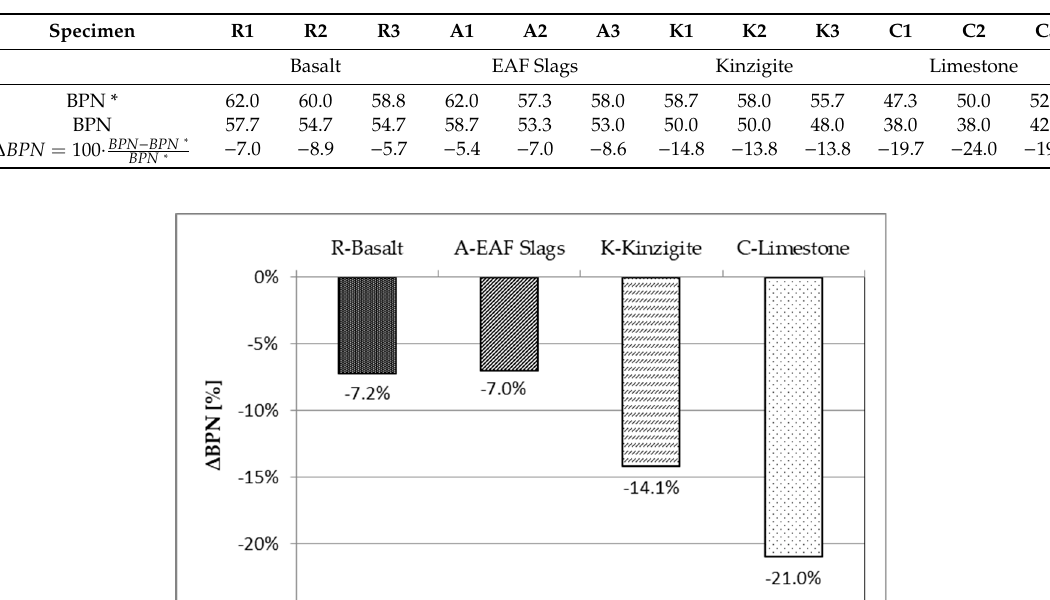
Table 5. British pendulum skid resistance test results.